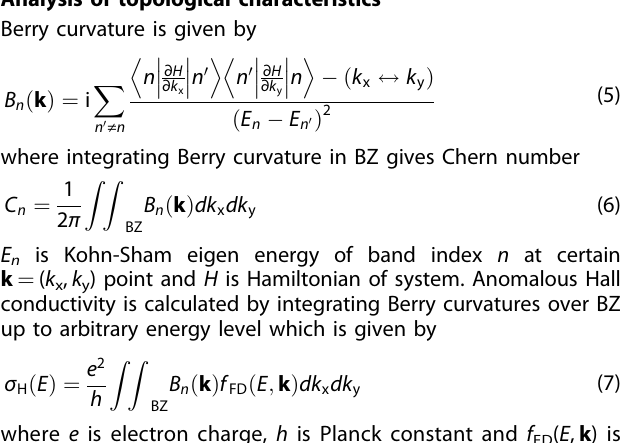
ffiffiffiffiffiffiffiffiffiffiffiffiffiffiffiffiffiffiffiffi Tr ð H 0 i H i 0 Þ